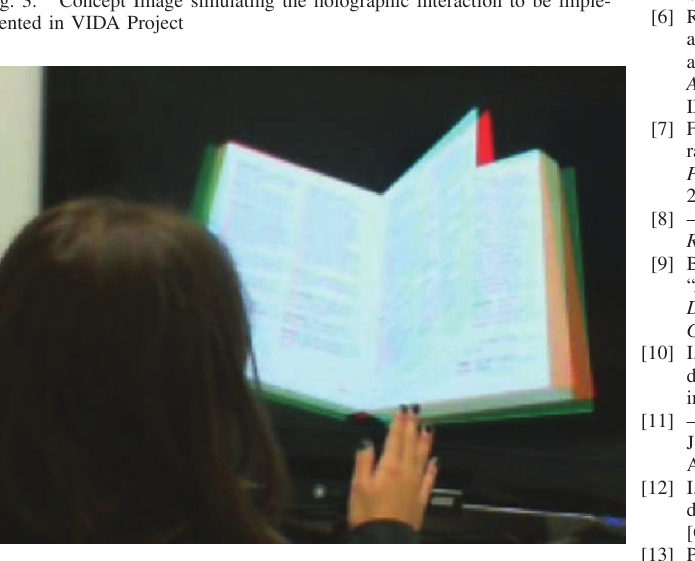
Fig. 4. user interacting with 3D Book (presented in anagliph